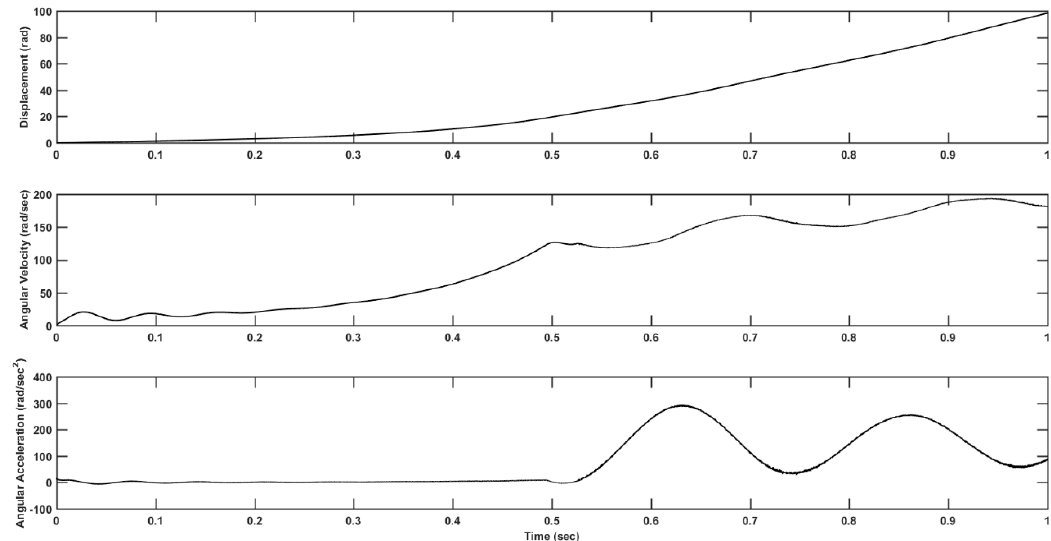
Figure 6. Predicted variations of displacement, angular velocity, and angular acceleration for the worn friction lining material during clutch engagement.